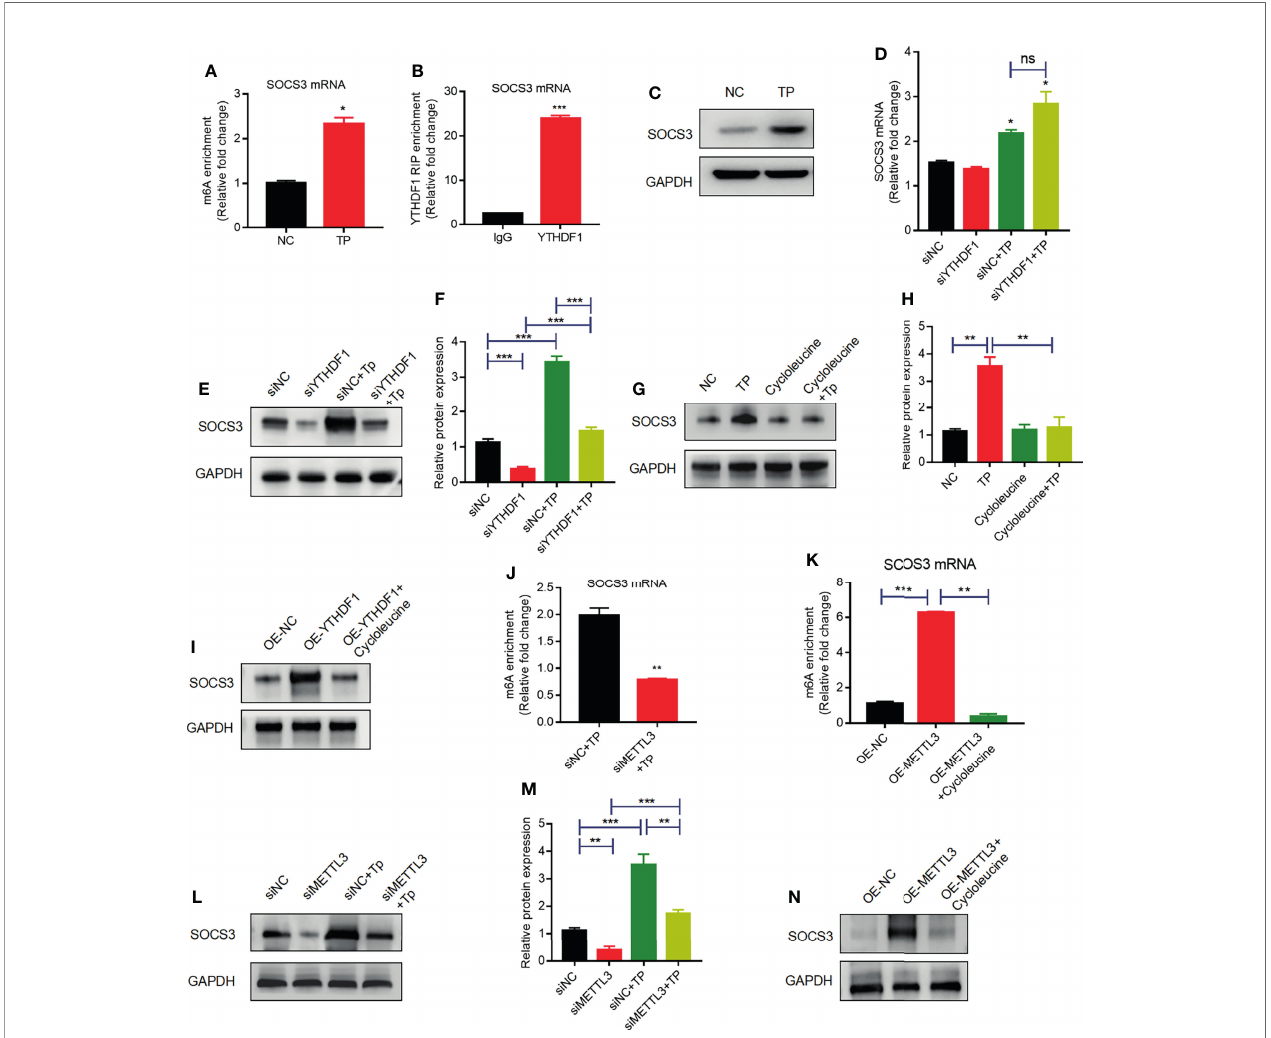
FIGURE 4 | YTHDF1 and METTL3 regulate SOCS3 translation in an m6A-dependent manner. (A) MeRIP-qPCR analysis of the m6A levels of SOCS3 mRNA in THP-1 cells with or without TP infection. Total RNA was isolated from the NC group or TP-infected group. Methylated RNA was immunoprecipitated and then RT-qPCR analysis of the immunoprecipitated RNA was performed. (B) RIP analysis of the interaction of SOCS3 mRNA with YTHDF1 protein in THP-1 cells with or without TP infection. Enrichment of SOCS3 with YTHDF1 was assessed by RT-PCR and normalized to the input. (C) Western blot analysis of SOCS3 in THP- 1 cells with or without TP infection. GAPDH was used as a control. (D) RT-PCR analysis of SOCS3 mRNA in THP-1 cells with or without TP infection following transfection with siNC or siYTHDF1. *P < 0.05 compared with siNC group. (E, F) Western blot analysis of SOCS3 in THP-1 cells with or without TP infection following transfection with siNC or siYTHDF1. GAPDH was used as a control. (G, H) Western blot analysis of SOCS3 in THP-1 cells with or without TP infection and with or without cycloleucine treatment. (I) Western blot analysis of SOCS3 in THP-1 cells transfected with control or YTHDF1 plasmid. (J) MeRIP-qPCR analysis of the m6A levels of SOCS3 mRNA in TP infected-THP-1 cells with or without METTL3 knockdown. (K) MeRIP-qPCR analysis of the m6A levels of SOCS3 mRNA in THP-1 cells transfected with control or YTHDF1 plasmid. (L, M) Western blot analysis of SOCS3 in THP-1 cells with or without TP infection following transfection with control or METTL3 knockdown. (N) Western blot analysis of SOCS3 in THP-1 cells transfected with control or METTL3 plasmid. *P < 0.05, **P < 0.01, ***P < 0.001; ns, no signi fi